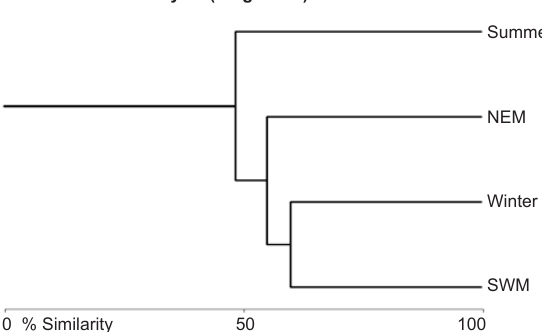
Figure 4. Sample based rarefaction curve for the different were observed in the SWM and only two unique Table 3. Abiotic and butterfly variation in different months